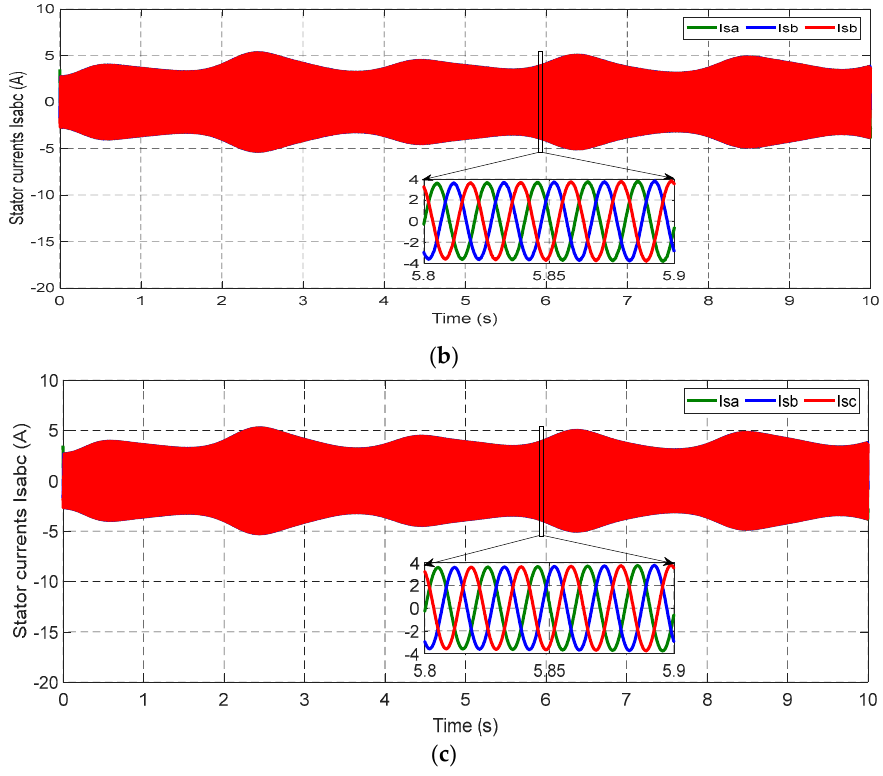
Figure 19. Currents i sabc , ( a ) DPC, ( b ) backstepping control, and ( c ) DPC ‐ ANN.